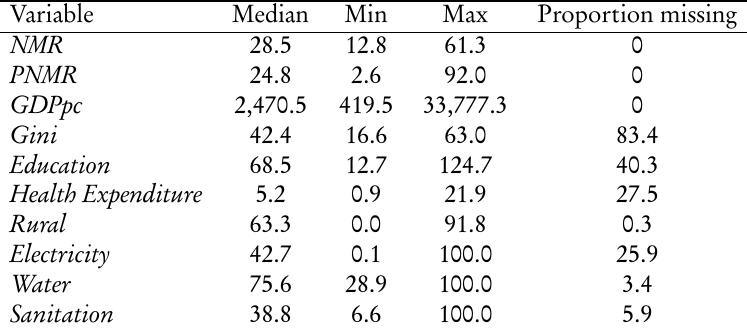
Descriptive statistics and proportion of missing for country-year